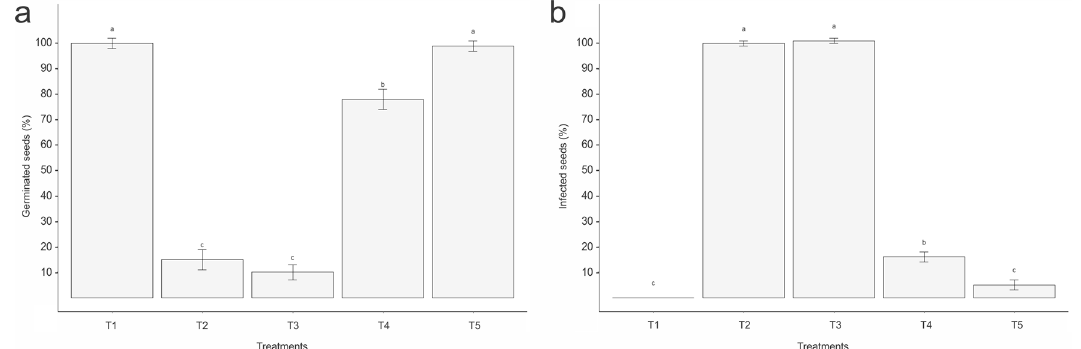
Figure 6. Control of Sclerotinia sclerotiorum on soybean seeds by inoculation of Bacillus velezensis CMRP 4489. Evaluation of the % of ( a ) germinated seeds and ( b ) uninfected seeds of Sclerotinia sclerotiorum . Bars represent the standard deviation based on 13 replicates per treatment. Letters indicate statistical difference by the Tukey test ( p <